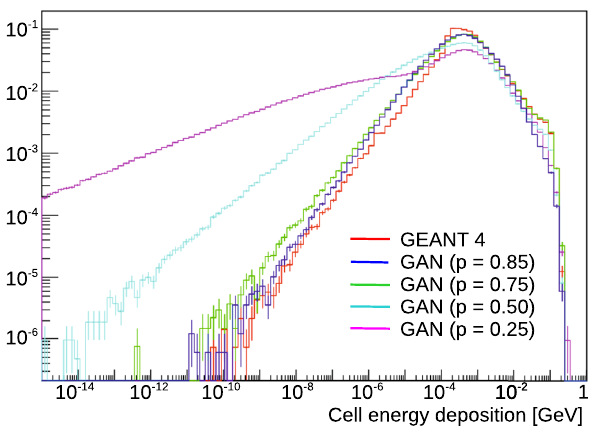
Fig. 3 The cell energy distribution for GEANT4 MC events (red) and GAN generated events after a pre-processing by taking the power of pixelintensities:power=0 . 85(blue);power=0 . 75(green);power=0 . 5 (cyan); power = 0 . 25